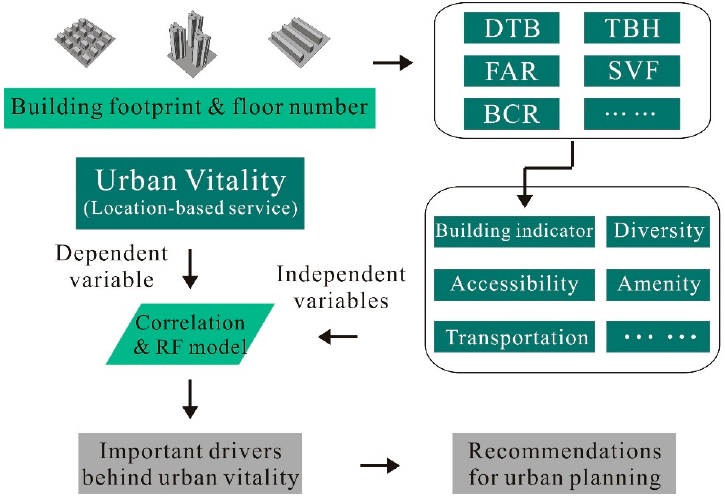
Figure 1. Methodological framework of this study.